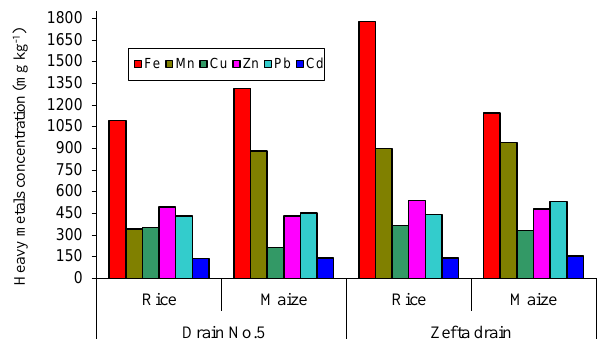
Figure 2. Concentration of heavy metals in maize and rice shoots grown in soils irrigated by water from Zefta drain and drain no.